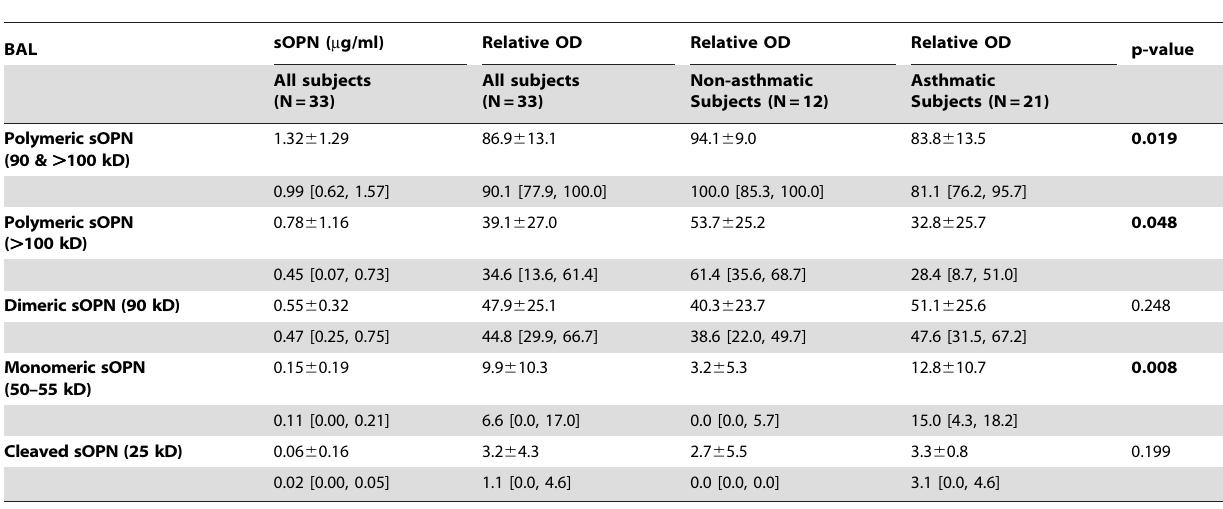
Table 1. Relative optical density (OD) for sOPN bands and OD-based concentration of sOPN in BAL.